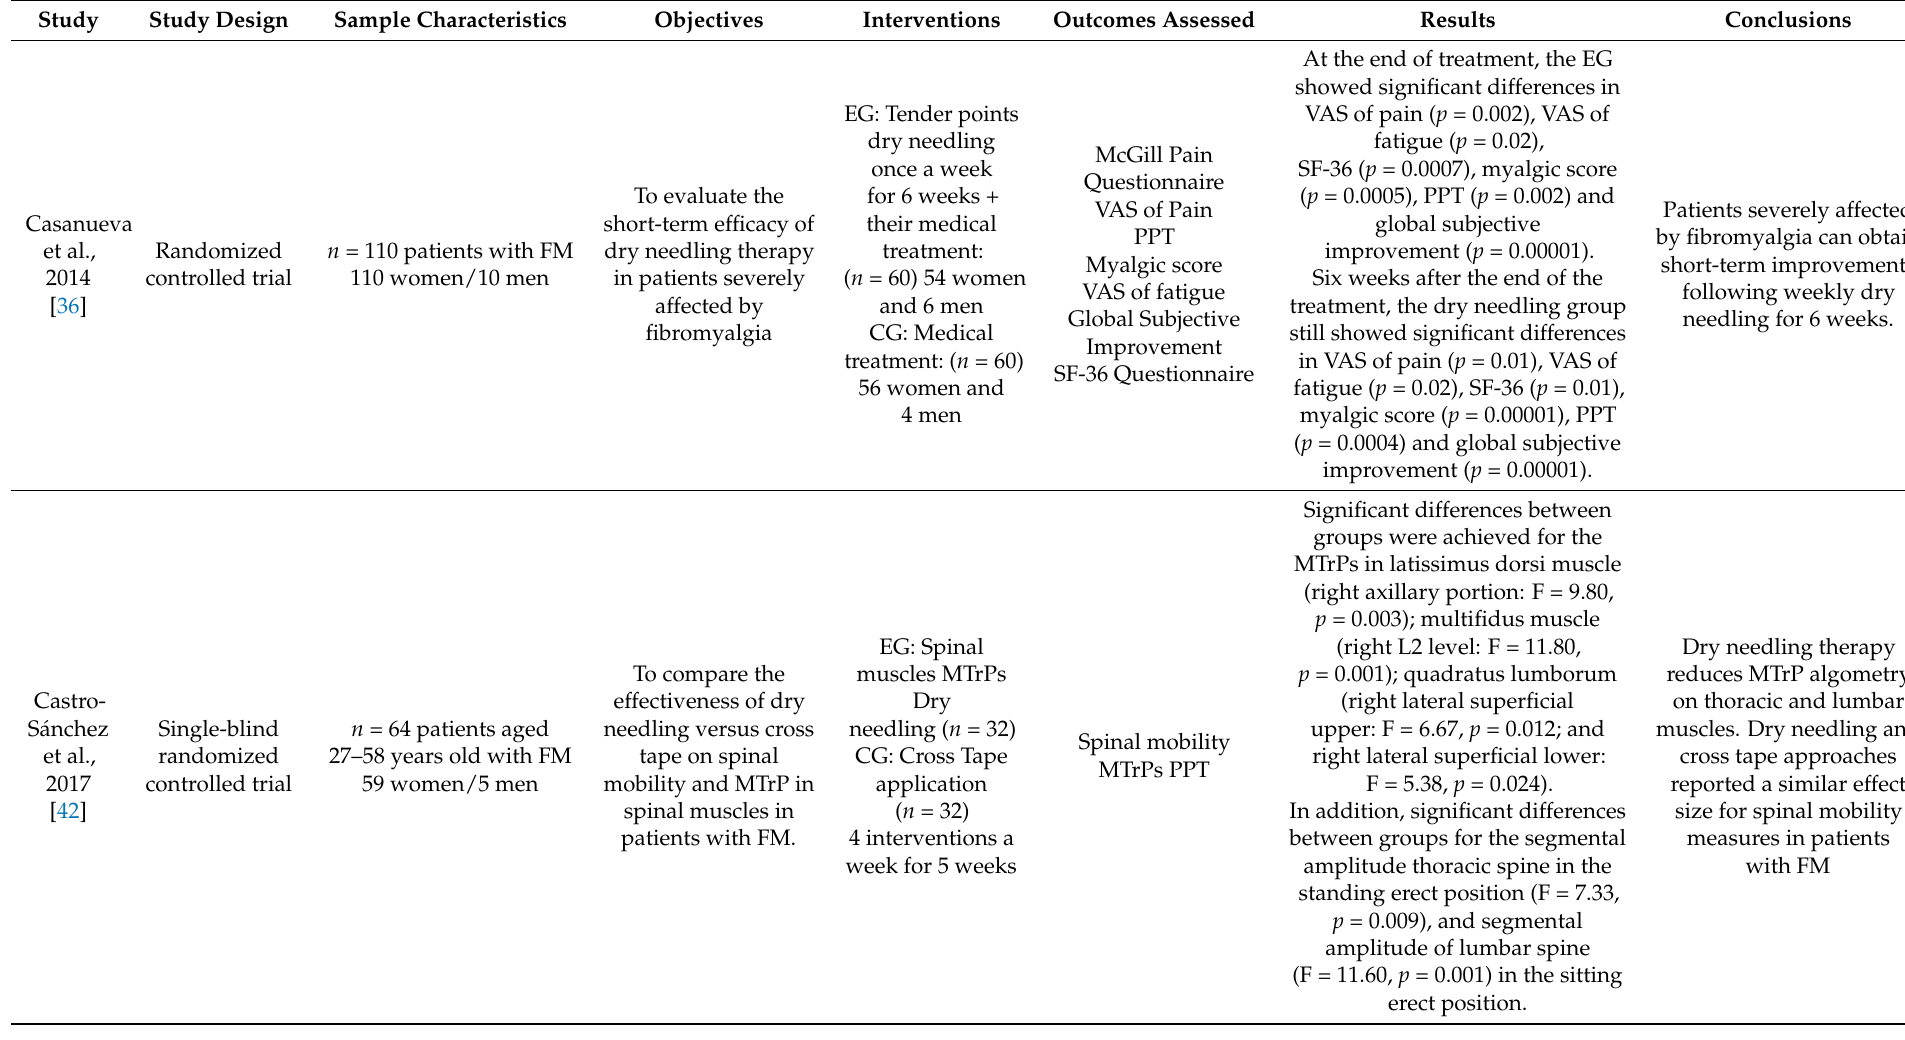
Table 2. Data Synthesis of the Studies applying Dry Needling in Patients with